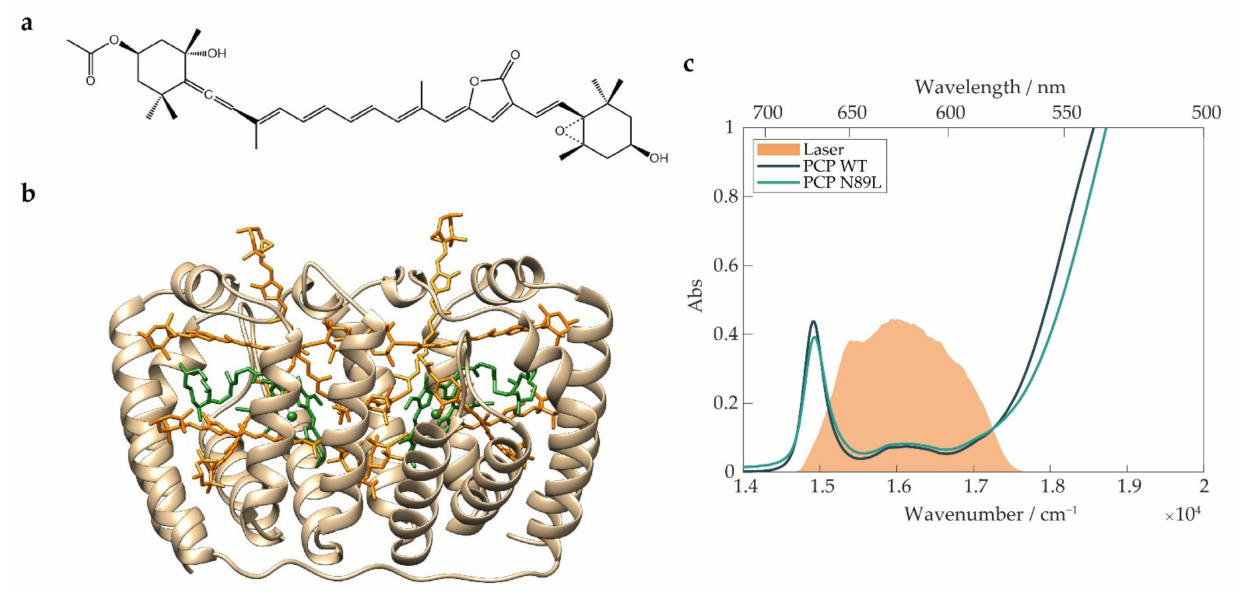
Figure 1. ( a ) Structure of the carotenoid Per. ( b ) Crystallographic structure of WT PCP, with the Per molecules colored in orange and the Chl a molecules colored in green. ( c ) Absorption spectra of WT PCP (blue) and its N89L mutant (green). The spectrum of the exciting pulses used in 2DES measurements is also shown (orange